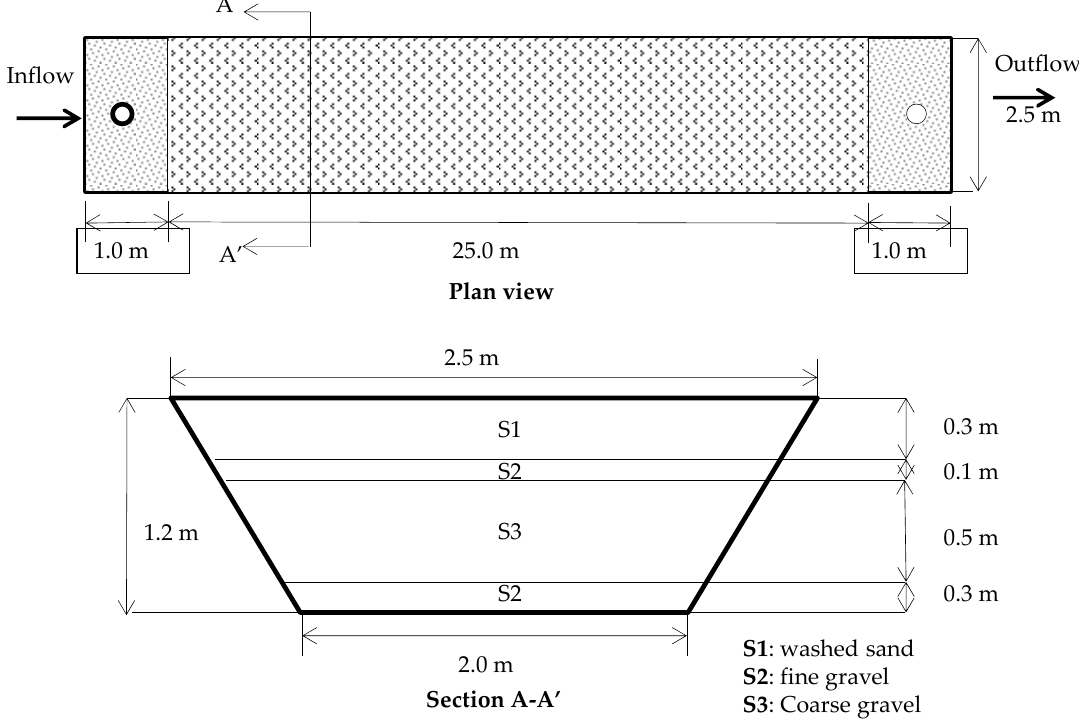
Figure 2. Horizontal subsurface constructed wetland (HSFCW) characteristics. Plan and section view. S1 washed sand, S2 fine gravel, and S3 coarse gravel.